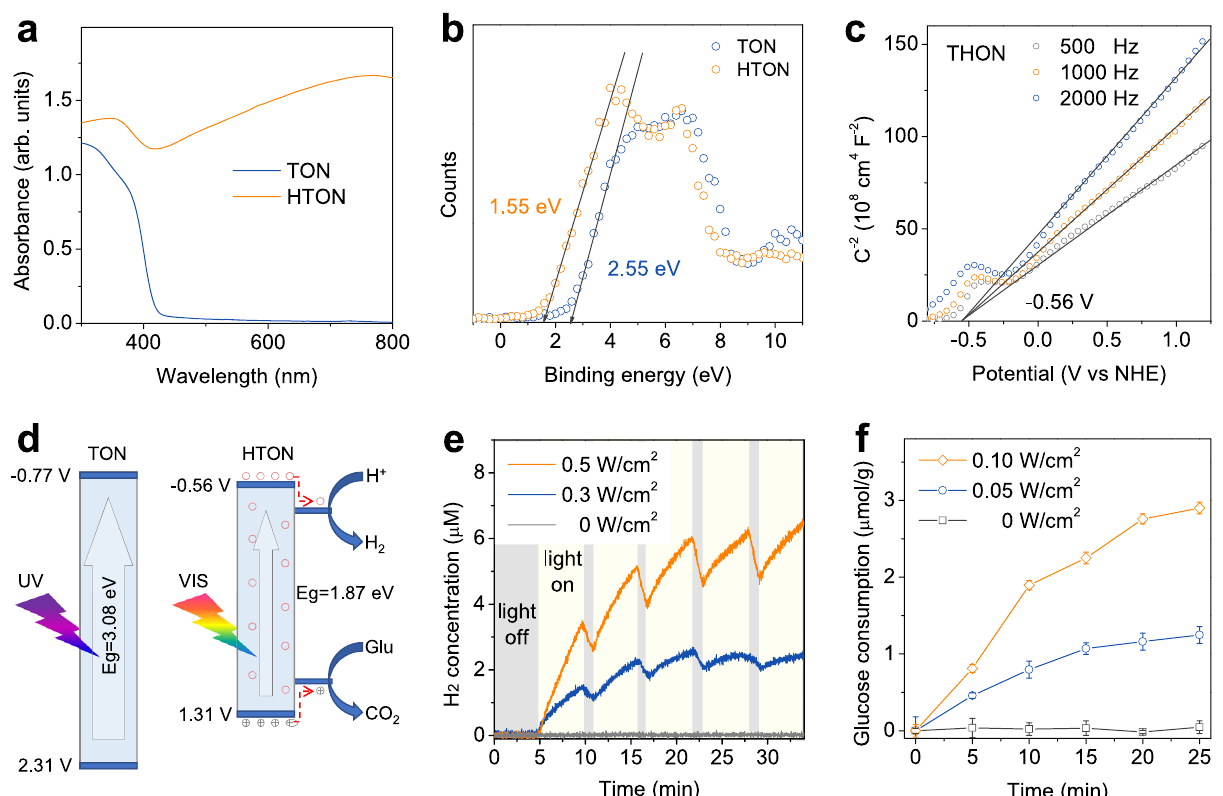
Fig. 3 | Band structure and VIS-photocatalytic behavior of the HTON nanoca- talyst for hydrogen generation and glucose consumption. UV-VIS absorption spectra ( a ), XPS-determined highest occupied molecular orbital (HOMO) levels of TON and HTON ( b ), Mott – Schottky plots of HTON ( c ), band structures (versusnormalhydrogenelectrode(NHE))ofTONand HTONandtheschematic illustration of the mechanism for VIS-photocatalytic hydrogen generation and